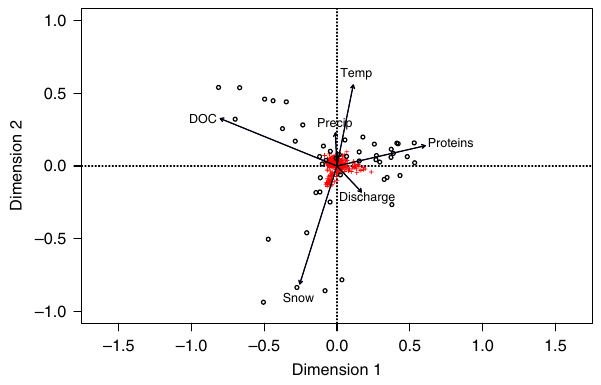
Fig. 4 Multivariate analysis of metabolites and environmental drivers using capscale. Constrained analysis of principal coordinates (capscale) ordinations are based on Bray-Curtis dissimilarity, computed from normalized peak intensities, and used to test for an association of metabolite composition (as derived from electron ionization gas chromatography mass spectrometry) with spatial, climate, and fl uvial characteristics. Red crosses represent individual metabolites, black circles represent samples, black vectors represent environmental variables with a signi fi cance level of <0.05 ( p -values based on analysis of variance with 1000 permutations; the relationship between all potential predictor variables and metabolites is shown in Supplementary Figure 8). DOC, dissolved organic carbon; Precip, month-averaged precipitation; Temp, month-averaged temperature; Proteins, EEMS region I; Discharge, daily average; Snow, daily snow depth at Wild